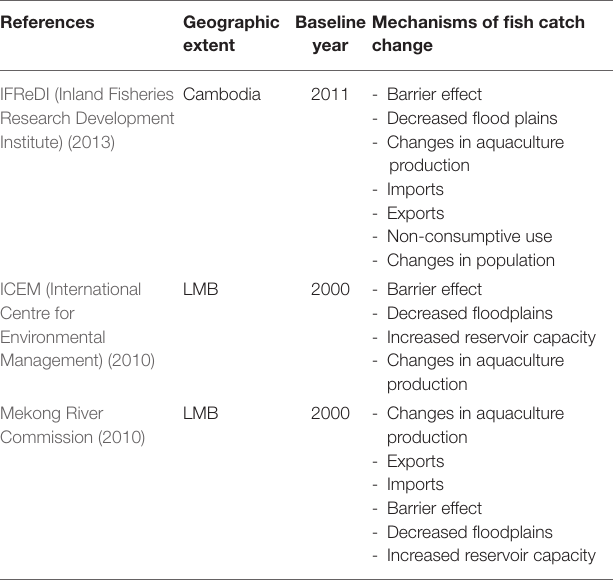
TABLE 1 | Summary of publications used for micronutrient